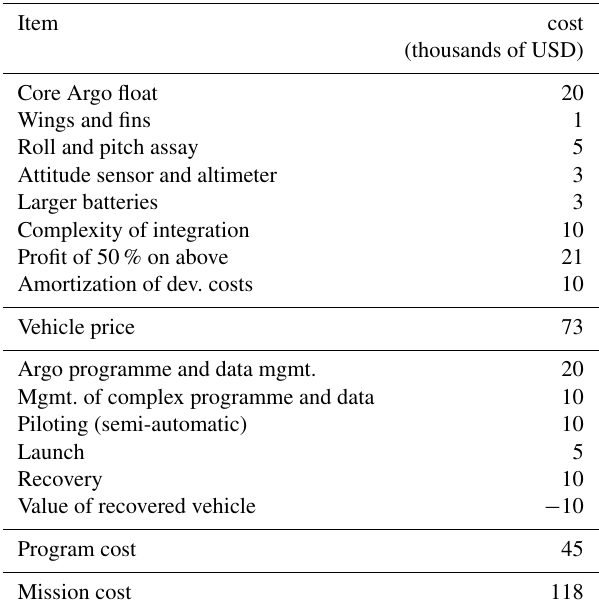
Table 2. Cost estimate for a slow glider mission based on Argo float costs and Argo programme costs. Item